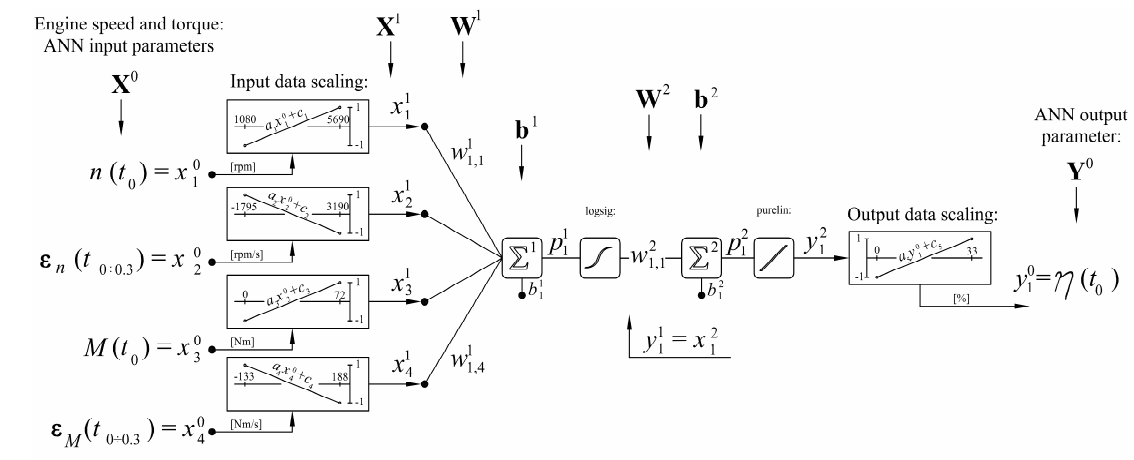
Figure 10. ANN used for engine e ffi ciency graph